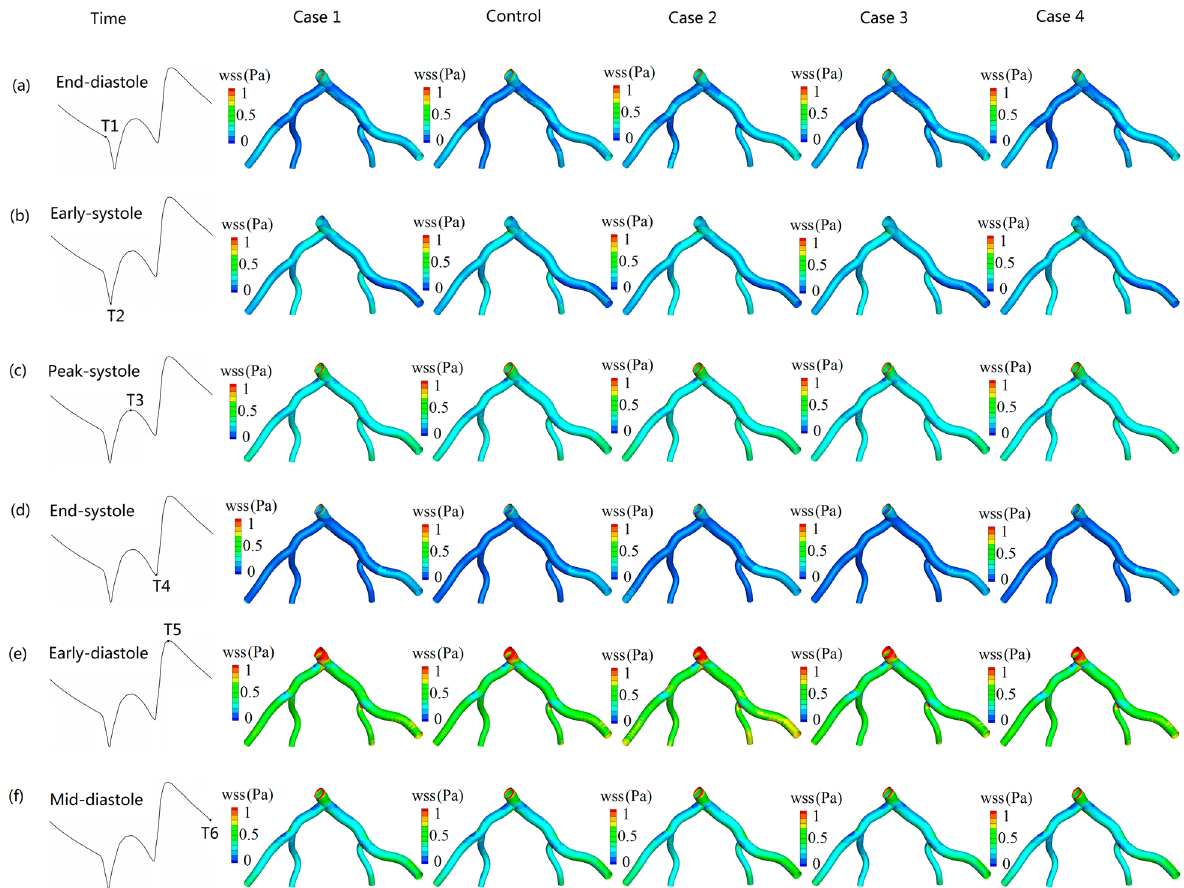
Figure 4. Wall shear stress distributions during the cardiac cycle for the five simulations. ( a – f ), respectively, represent the period of end-diastole, early-systole, peak-systole, end-systole, early-diastole,